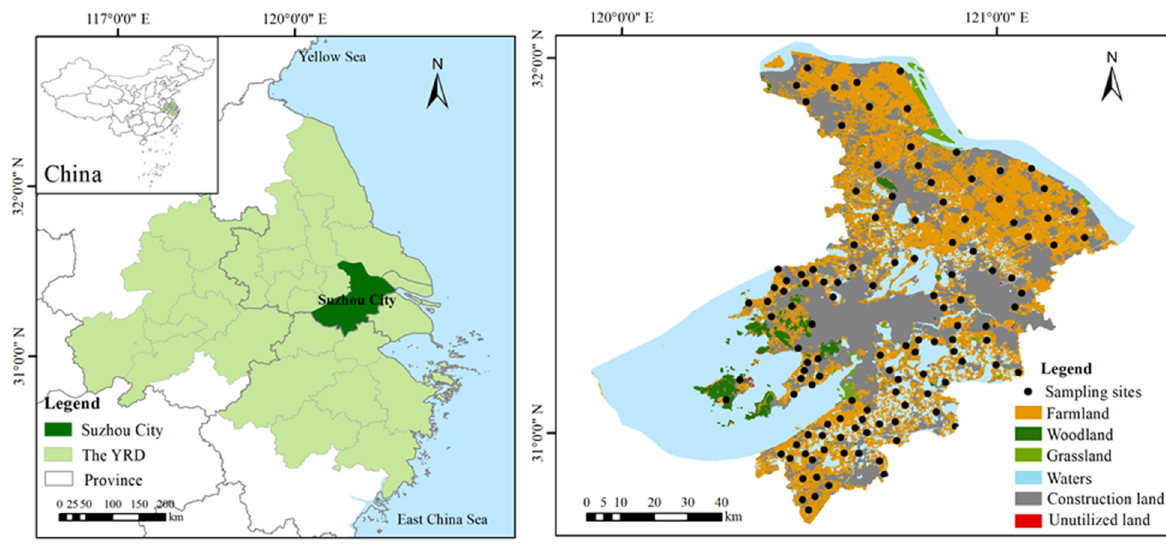
Figure 1. Study area and sampling sites.